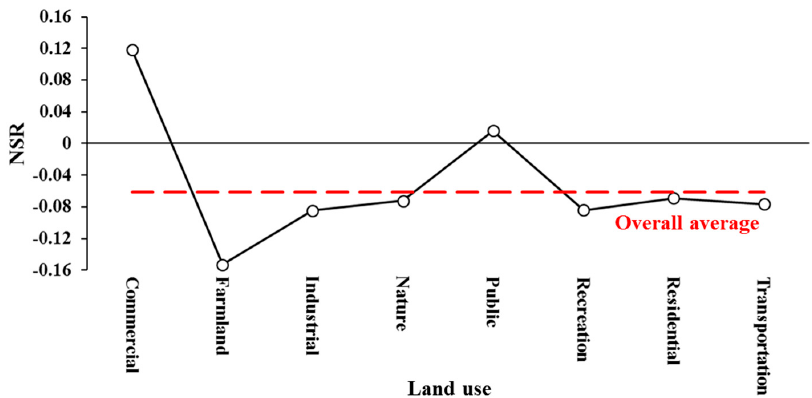
Figure 4. NSR s by land use categories. NSR : net sentiment rate.